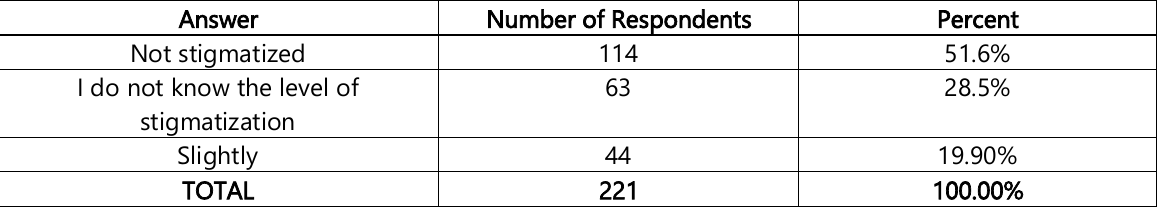
Table 6: Reflection of the Perception of the Level of Stigmatized Subject or Persons who Cause Tax Evasion (Source: Authors’ calculation)